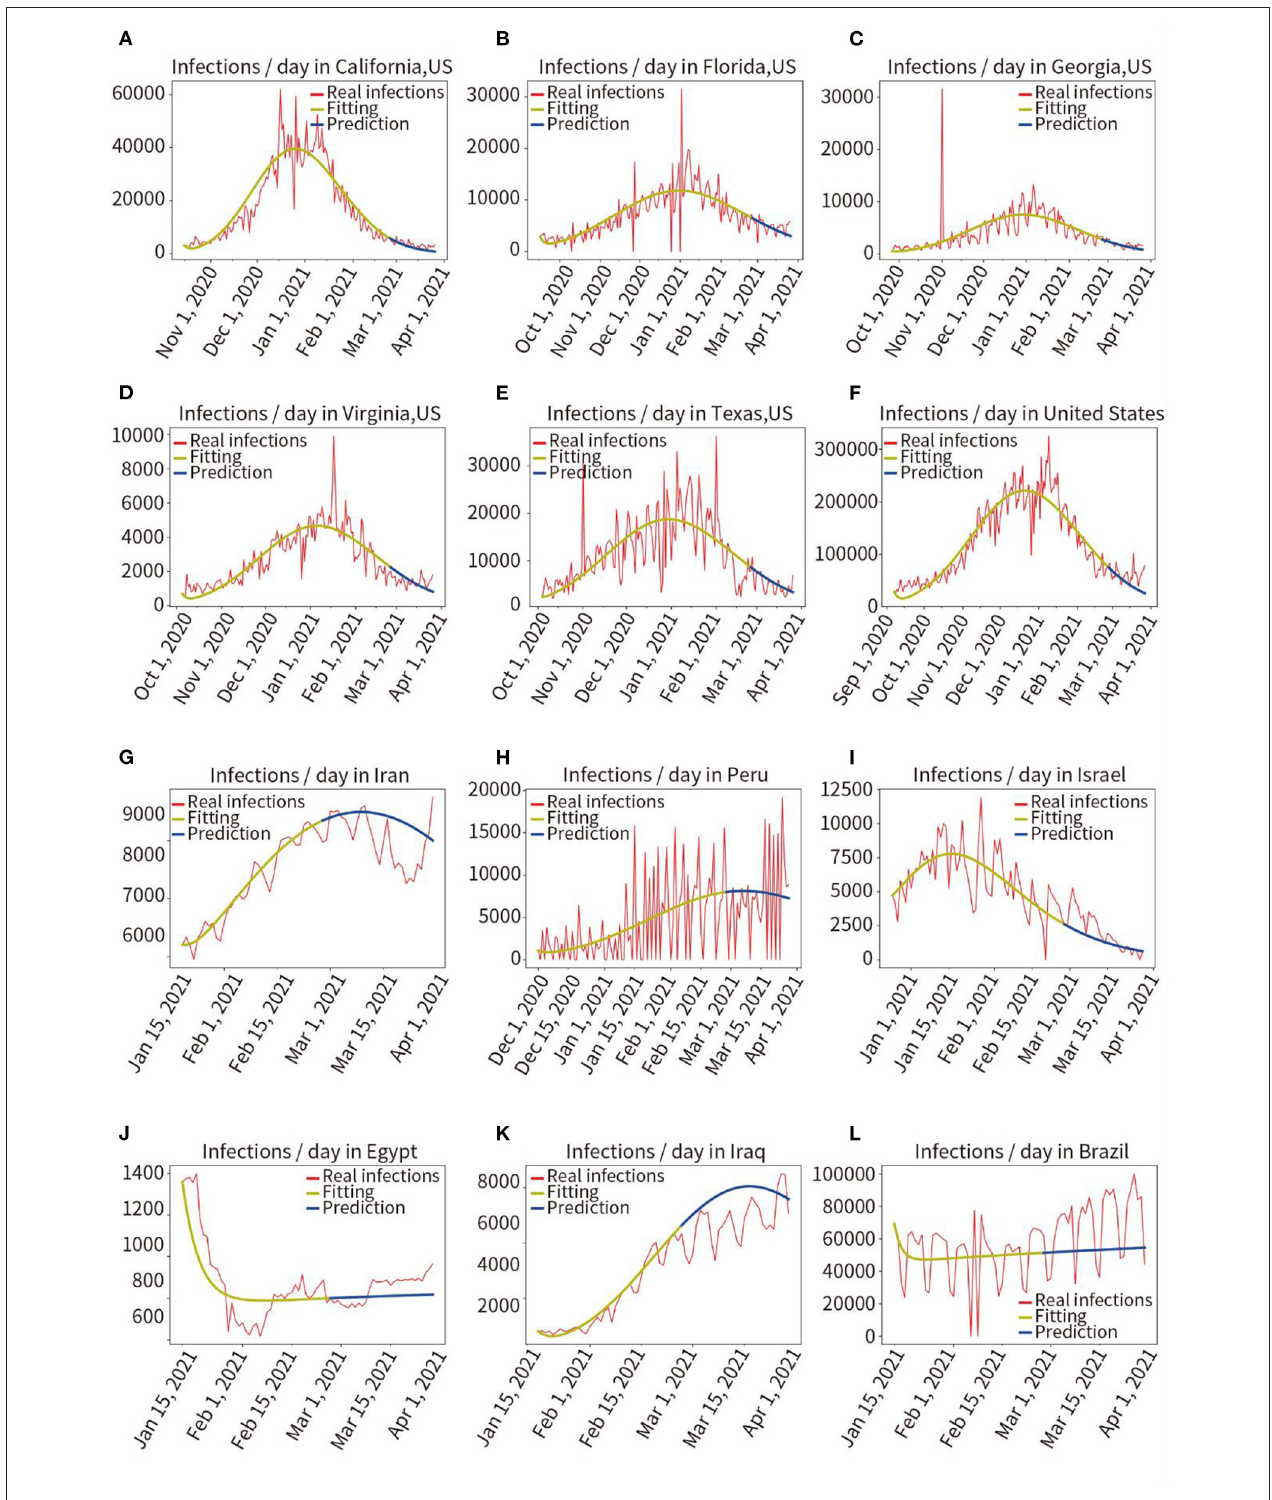
FIGURE 3 | Retrospective quantitative prediction for 12 countries or regions. Actual infected individuals are represented by red curves. Fitted infections are represented by yellow curves. Predicted infections are represented by blue curves. (A) California, (B) Florida, (C) Georgia, (D) Virginia, (E) Texas, (F) the United States, (G) Iran, (H) Peru, (I) Israel, (J) Egypt, (K) Iraq, (L) Brazil.